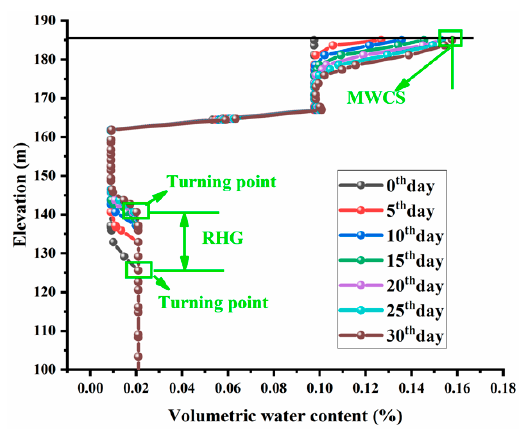
Figure 11. Variations in the volumetric water content